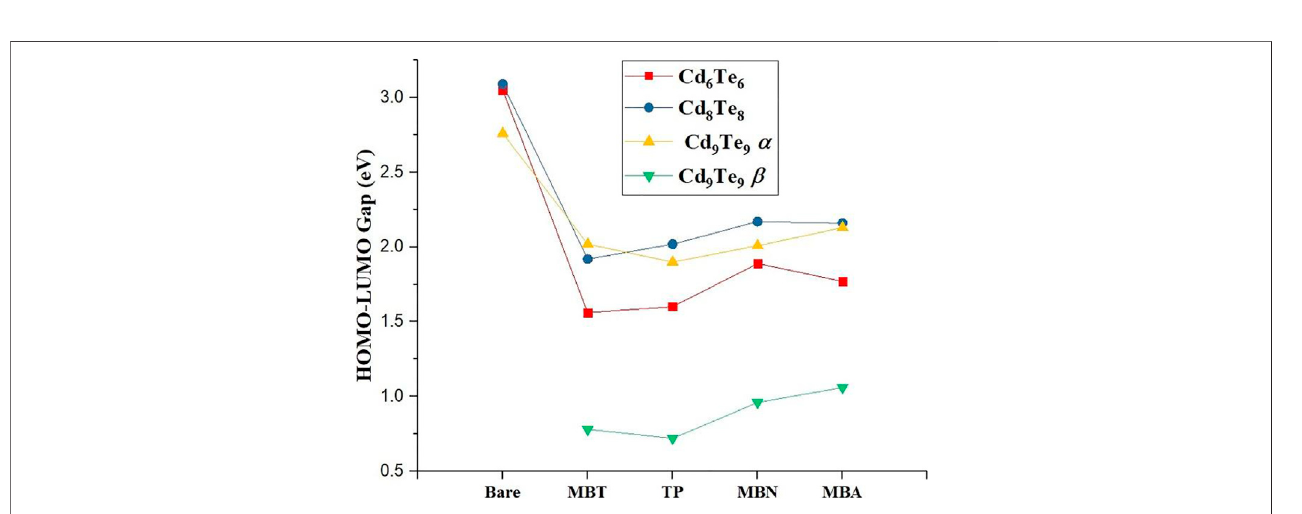
FIGURE 8 | HOMO-LUMO gap (eV) for bare and capped Cd n Te n L n ( n (cid:1) 6, 8, and 9) QDs.